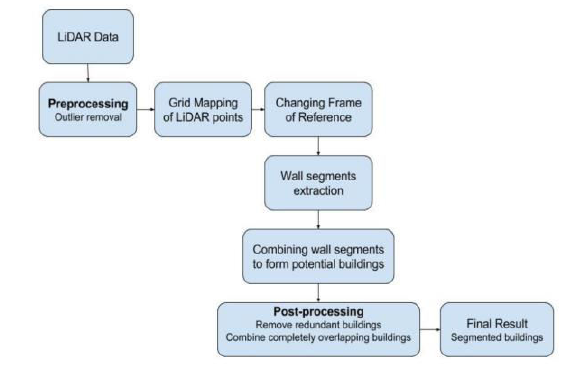
Figure 4. Flowchart of the building segmentation algorithm